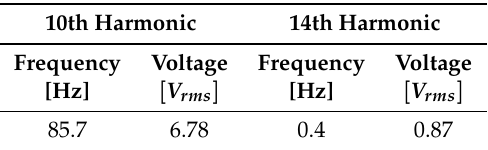
Table 6. Synchronous speed at direct rotation